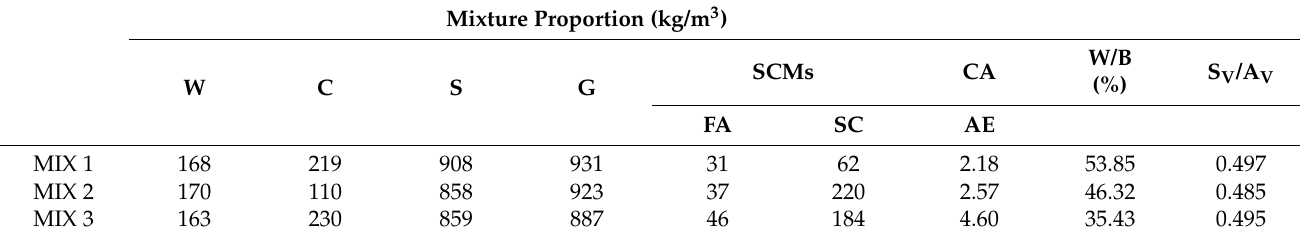
Table 2. Properties of the concrete cylinders used in this